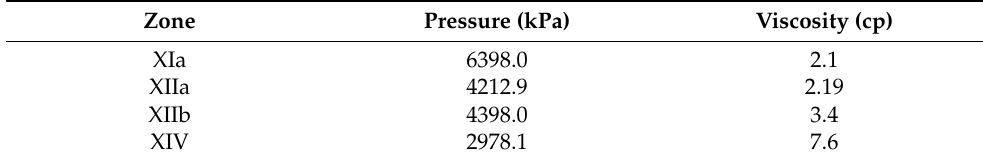
Table 2. Pressure and viscosity of Kashkari oil field crude oil at standard temperature.